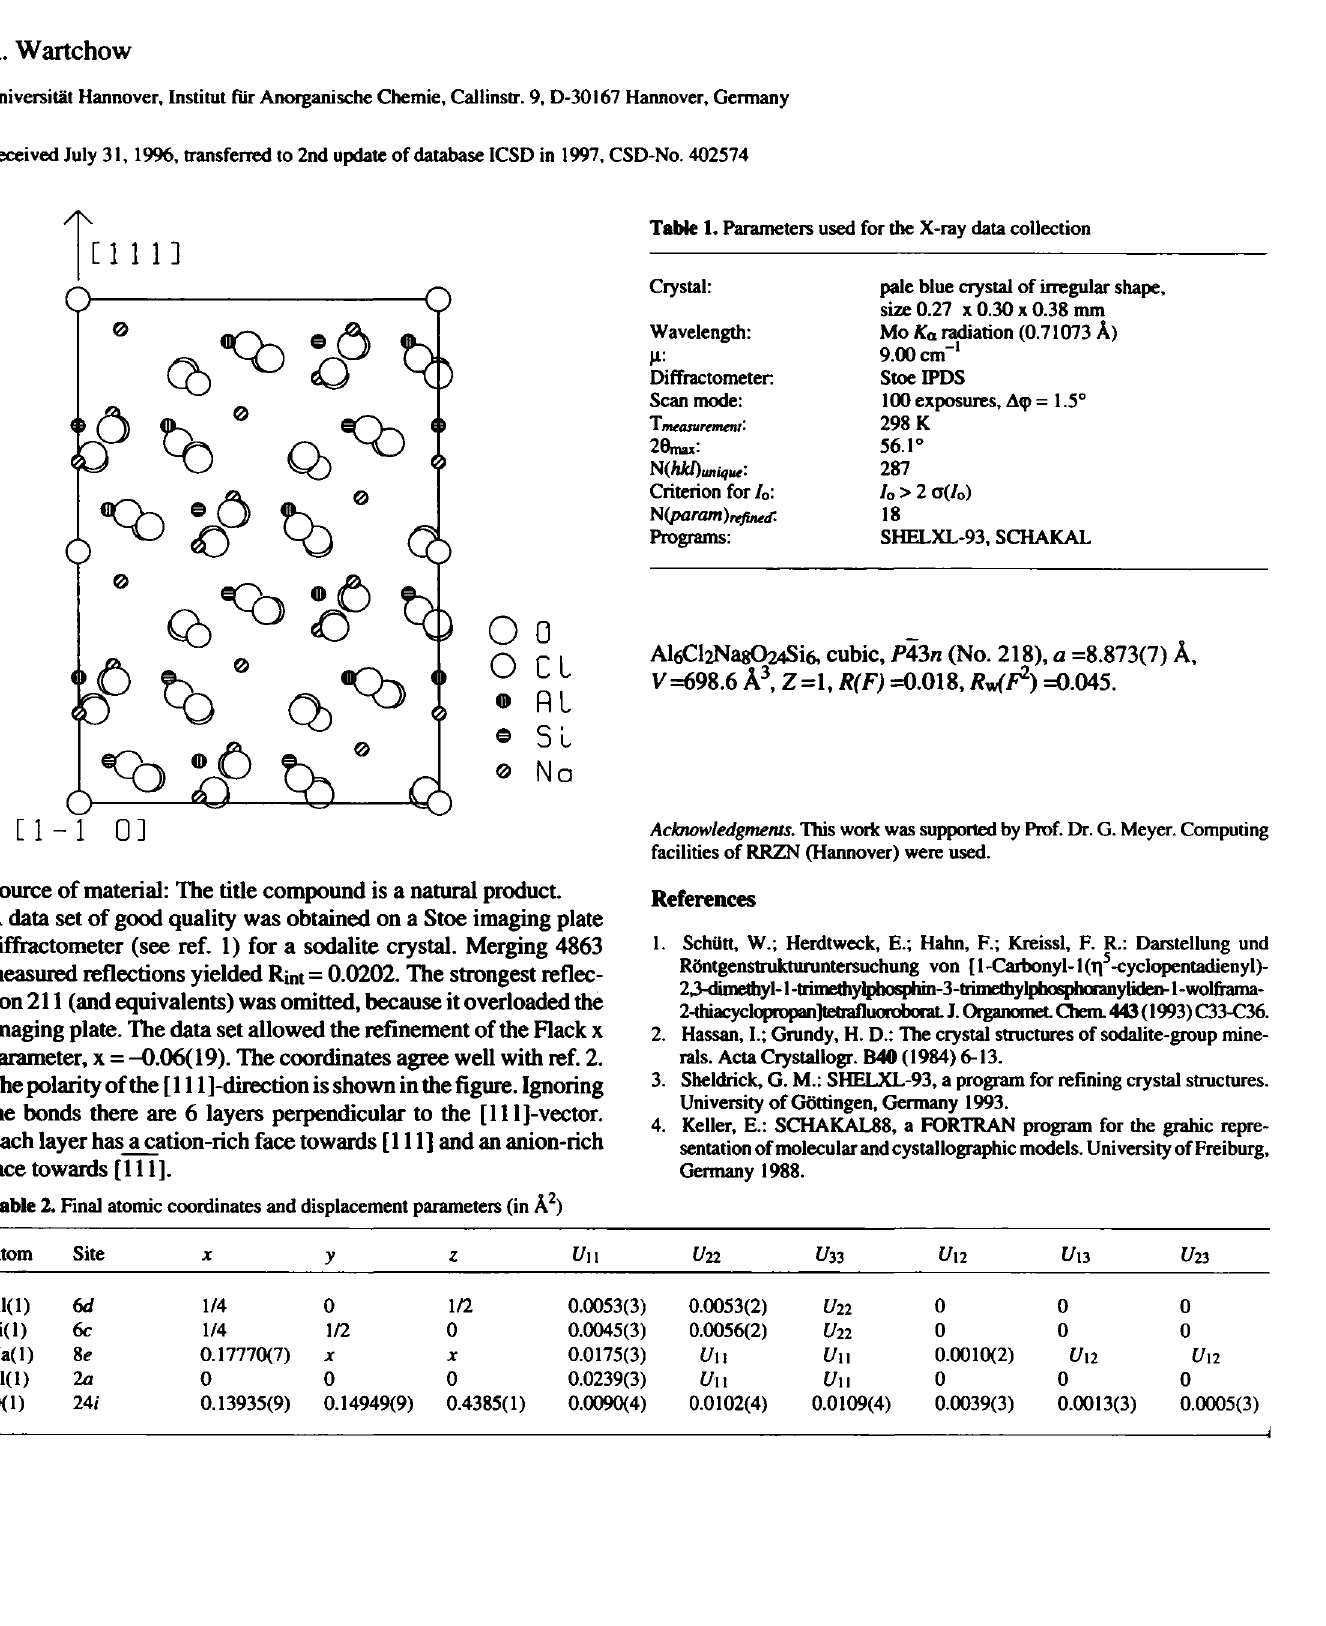
Table 1. Parameters used for the X-ray data collection